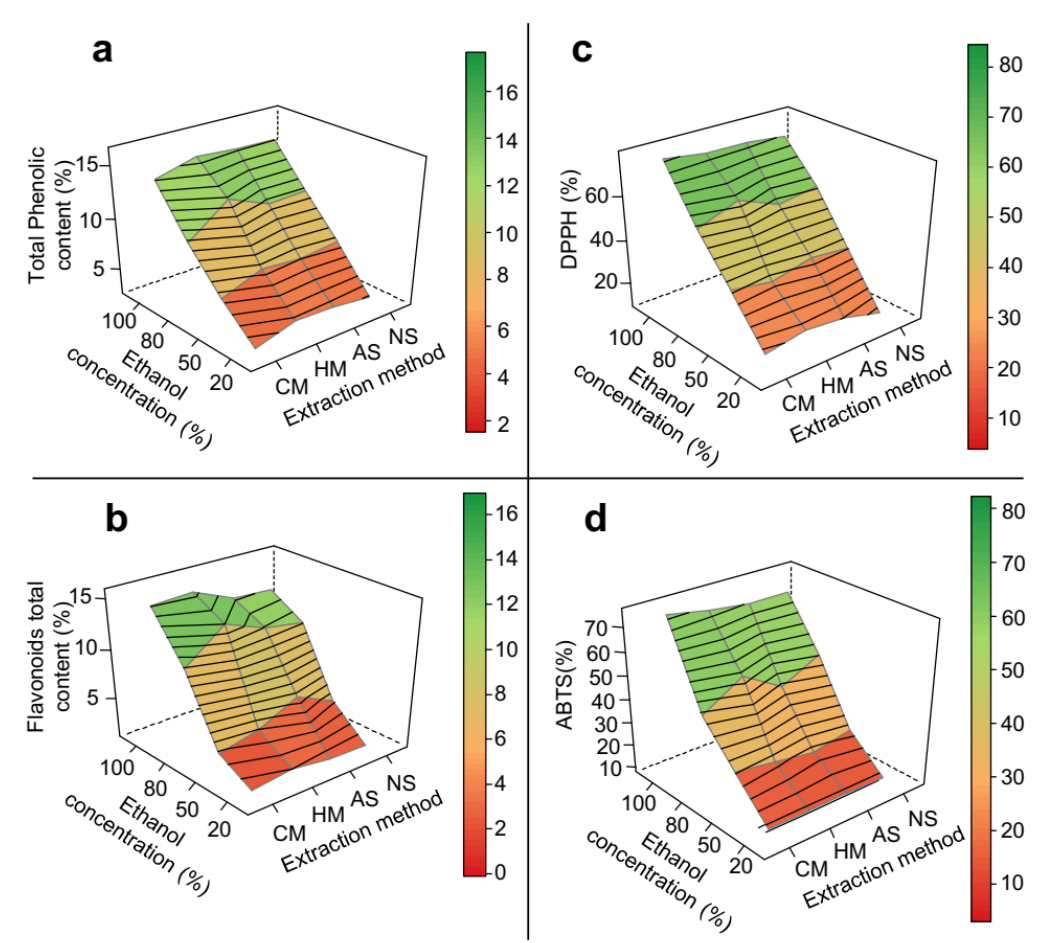
Figure 2. 3D response surface graph of the optimization of phenolic extraction from P. insignis mesocarp. ( a ) Total phenolic, ( b ) Total flavonoid, ( c ) DPPH, and ( d ) ABTS. CM = cold maceration; HM = hot maceration; AS = acid sonication; NS = neutral sonication; DPPH = Antioxidant capacity by DDPH assay; ABTS = Antioxidant capacity by DDPH assay.